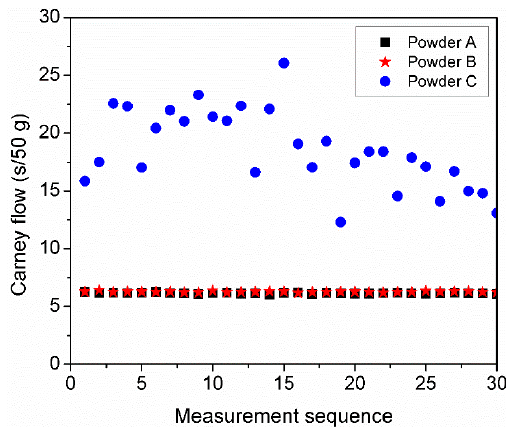
Figure 6. Carney flow variations of powders A, B, and C after oven drying and exposure to RH 40%.